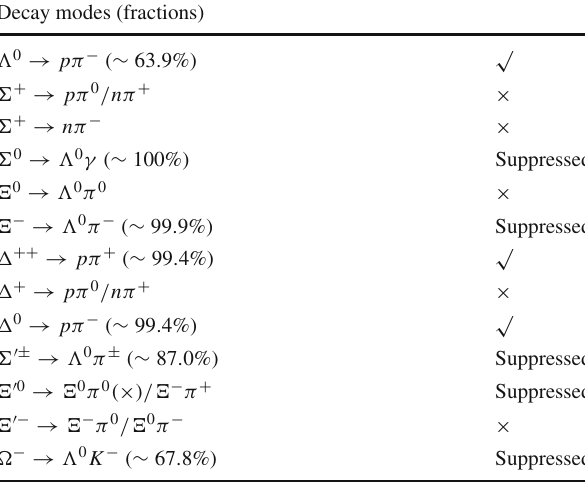
Table 5 Primary decay modes of light baryons Decay modes (fractions)